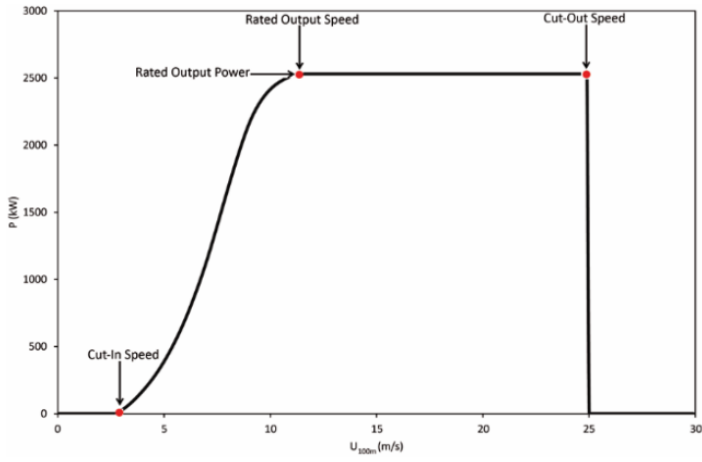
Figure 2. Power curve used to calculate empirical annual wind energy yield ( AEY emp ) and modeled annual wind energy yield ( AEY mod ) depending on wind speed in 100 m above ground level (AGL) ( U 100m ).